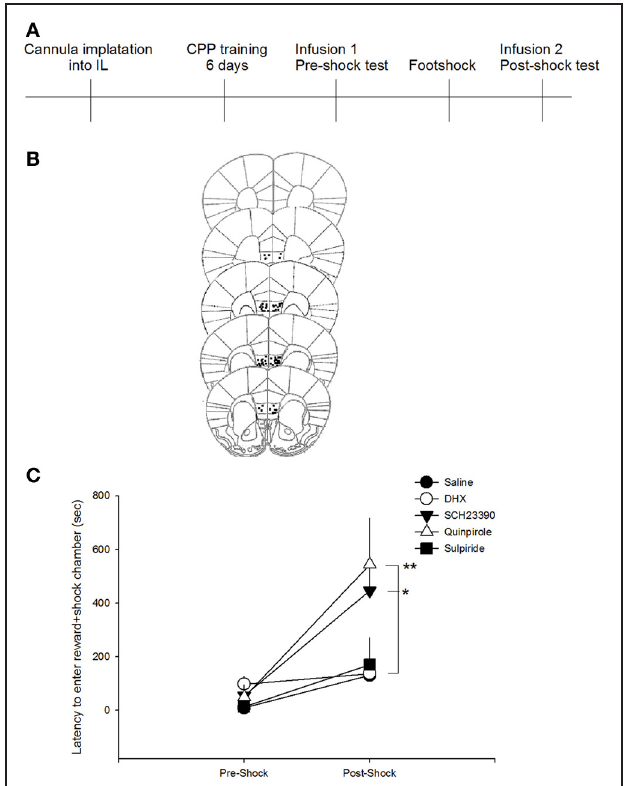
FIGURE 2 | D1 antagonism or D2 agonism reduce compulsive-like reward seeking. (A) Experimental timeline. Mice received infusions of drugs into the IL only during test sessions to ensure that effects were on the expression, not acquisition, of compulsive-like behavior. (B) Only mice whose cannula could be confirmed to be within the IL were included in behavioral analyses. Images modified from Paxinos and Franklin (2001). (C) Antagonism of the D1 receptor with SCH23390 or agonism of the D2 receptor with quinpirole in the IL reduced compulsive-like reward seeking as indicated by an increase in latency to enter the reward-paired chamber only after pairing with foot shock (adverse consequence). ∗ p < 0 . 05, ∗∗ p < 0 .